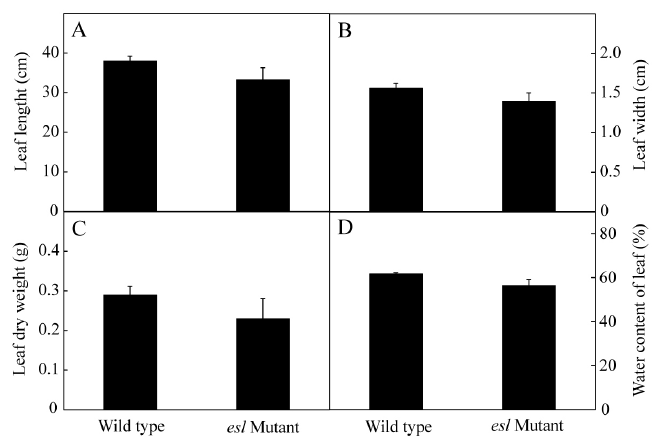
Figure 3. Comparisons of the ( A ) leaf length, ( B ) leaf width, ( C ) leaf dry weight, and ( D ) water content of leaves between the esl mutant rice and its wild-type cultivar. Vertical bars represent standard errors ( n = 3).